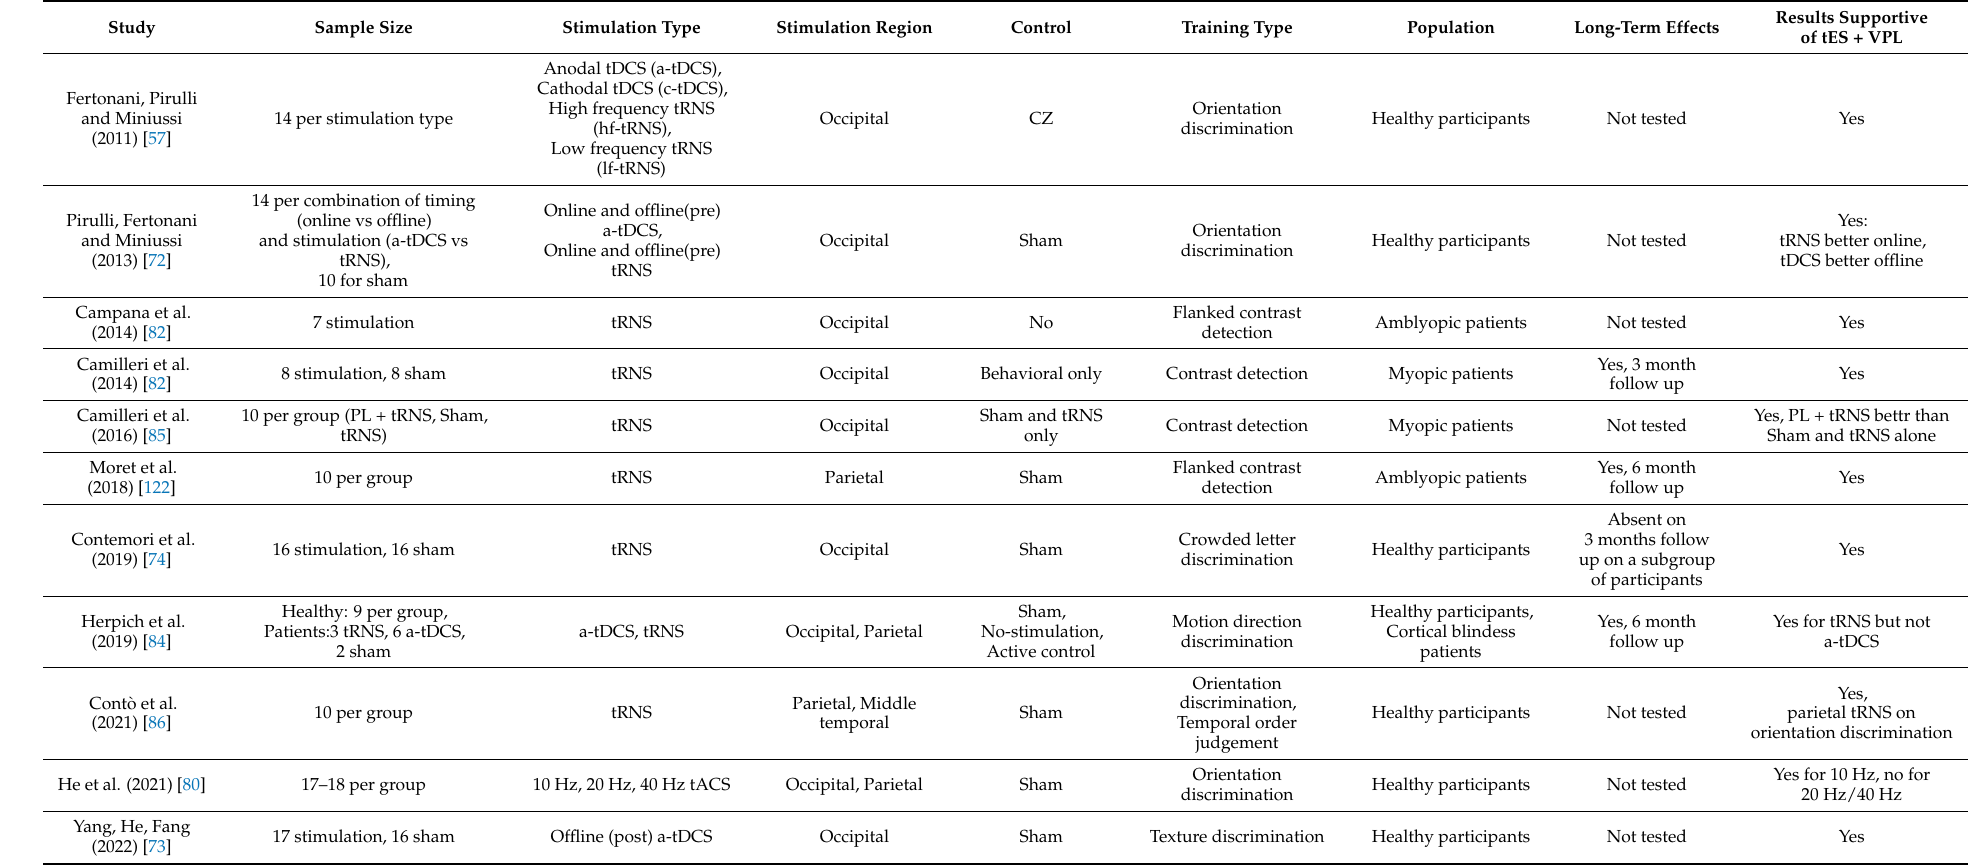
Table 1. Overview of PL studies using